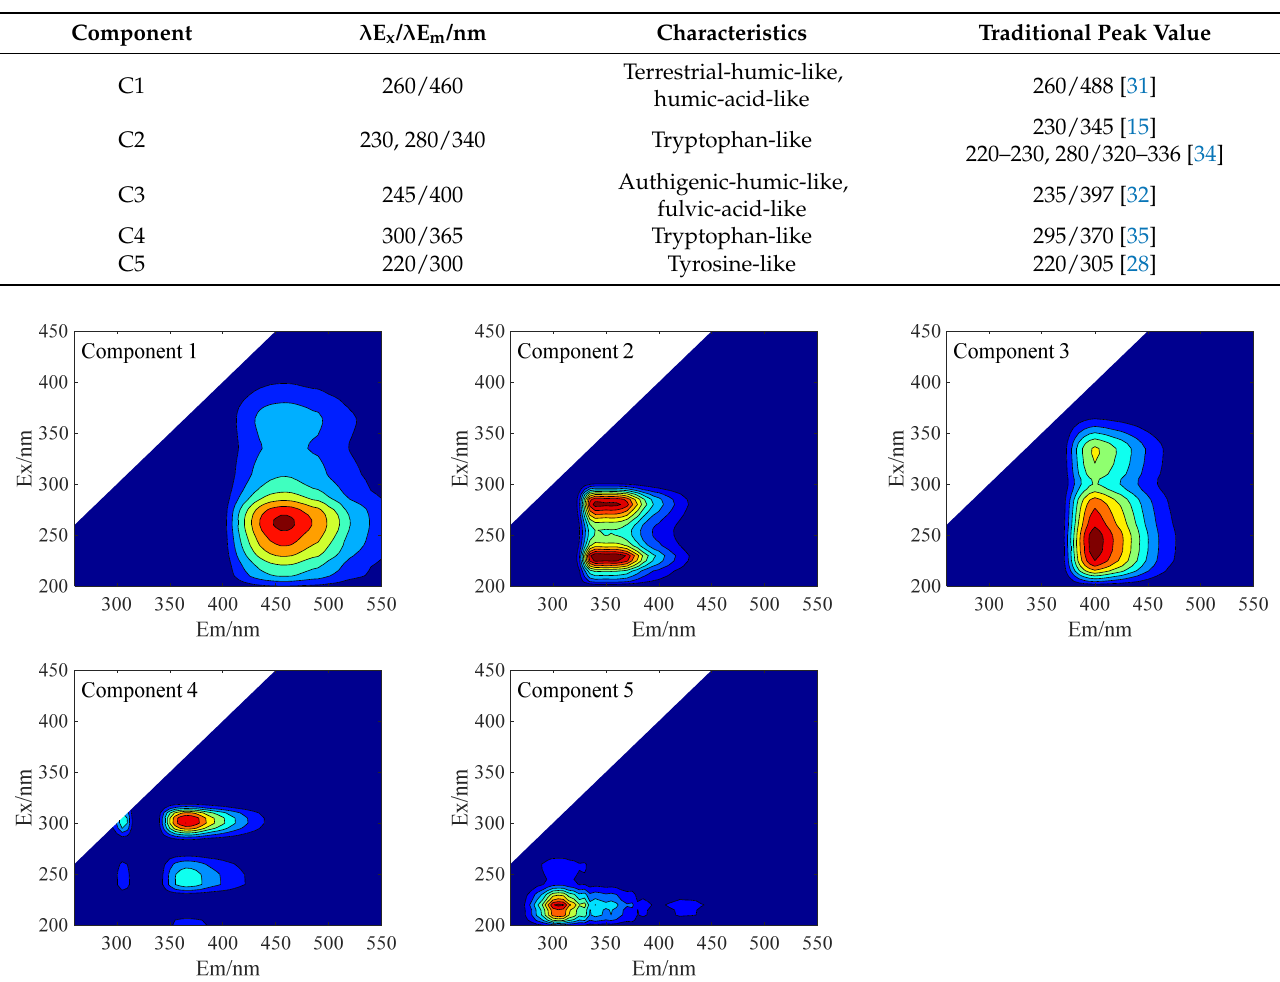
Table 2. Spectral characteristics of five fluorescent components in the overlying water of the surface of Shahu Lake.